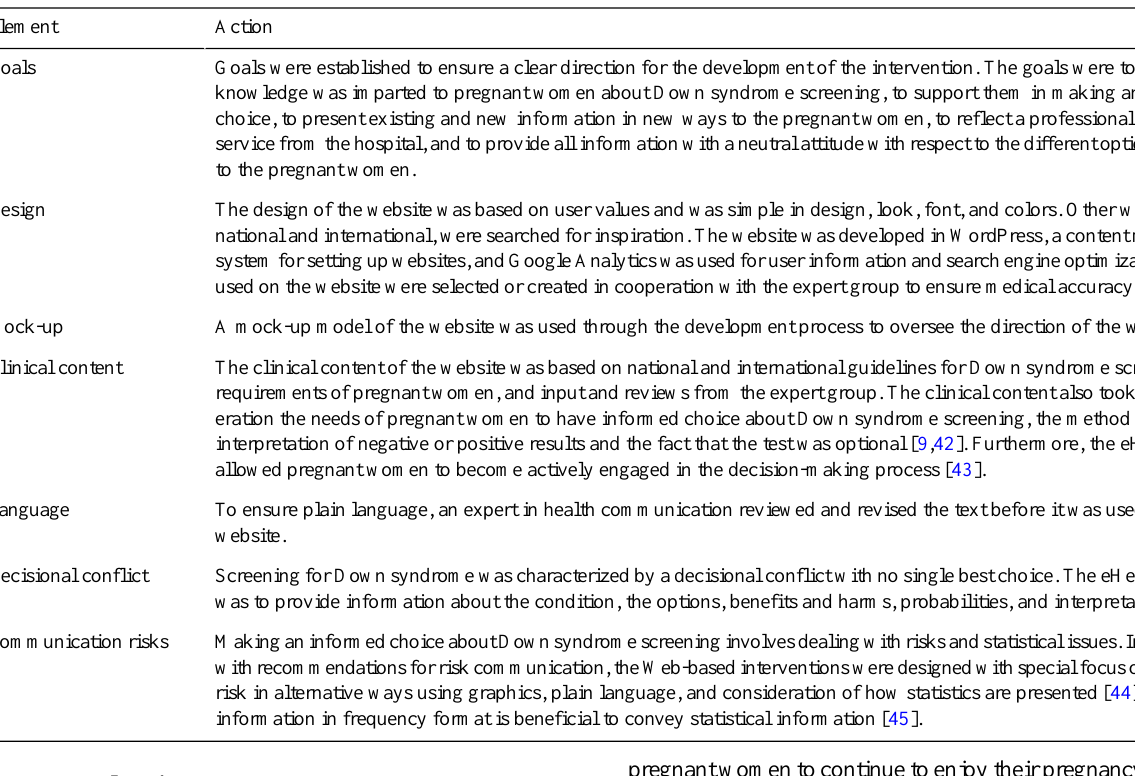
Table 1. Important elements in the development of the eHealth